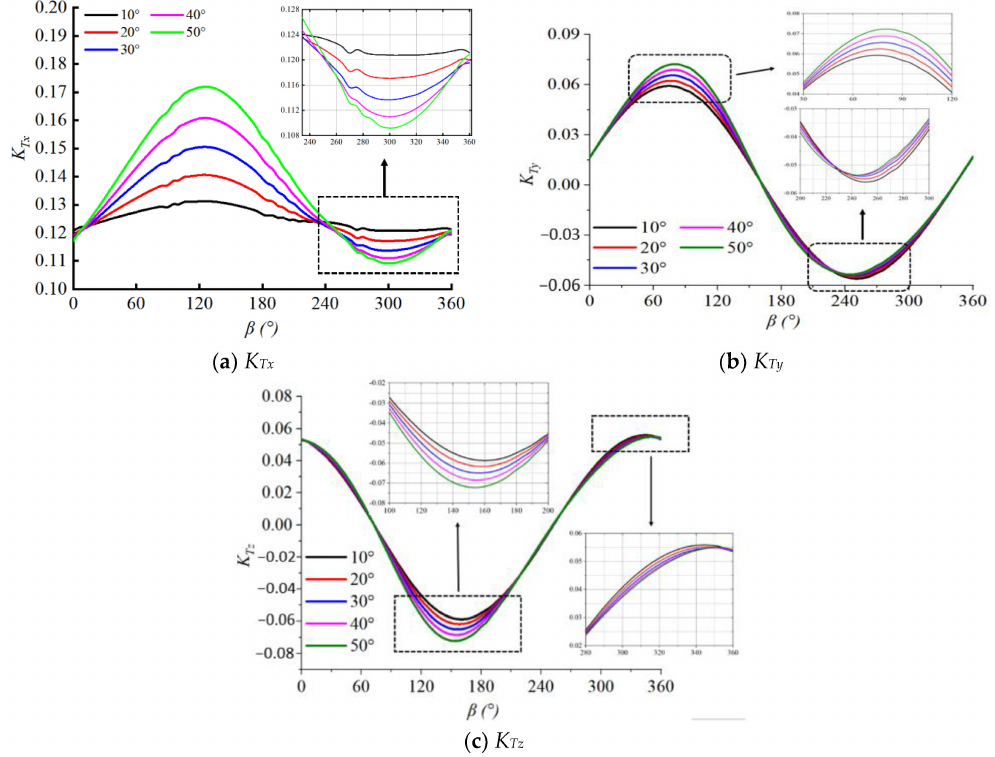
Figure 14. Single-blade load in stable condition ( J = 0.2): ( a ) K Tx ; ( b ) K Ty ; ( c ) K Tz